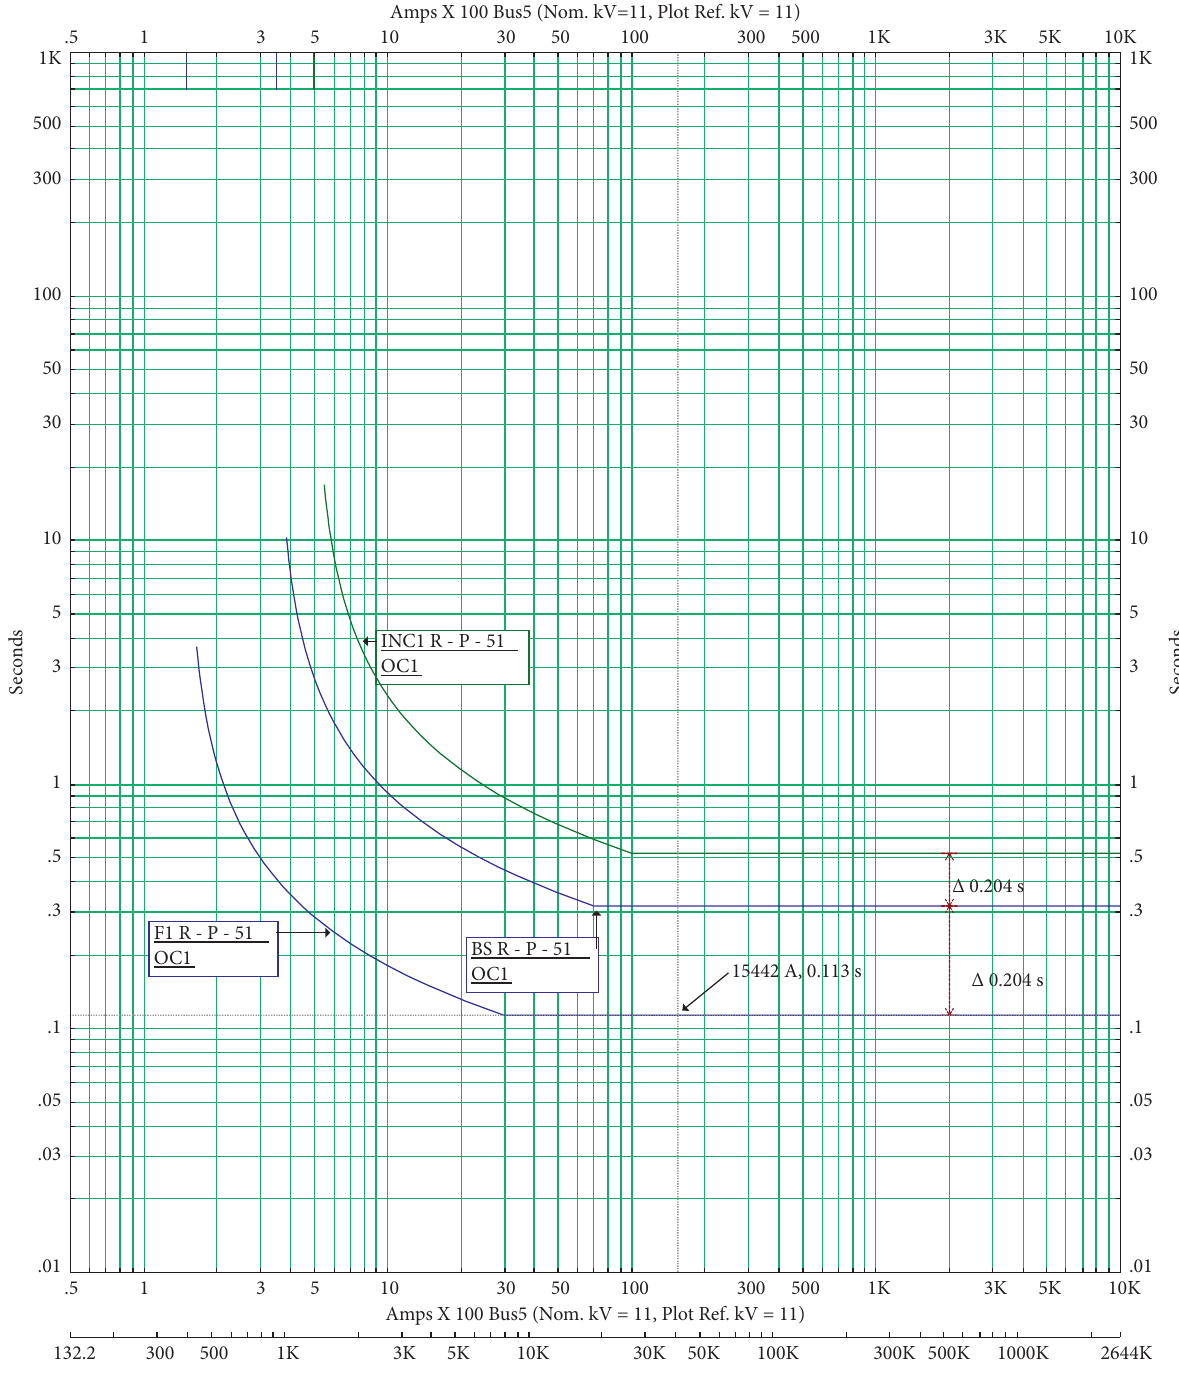
Figure 10: Relays (F1, BS, INC1) coordination with traditional method. Table 2: Relays operation time for feeders 1 and 6 fault, with traditional